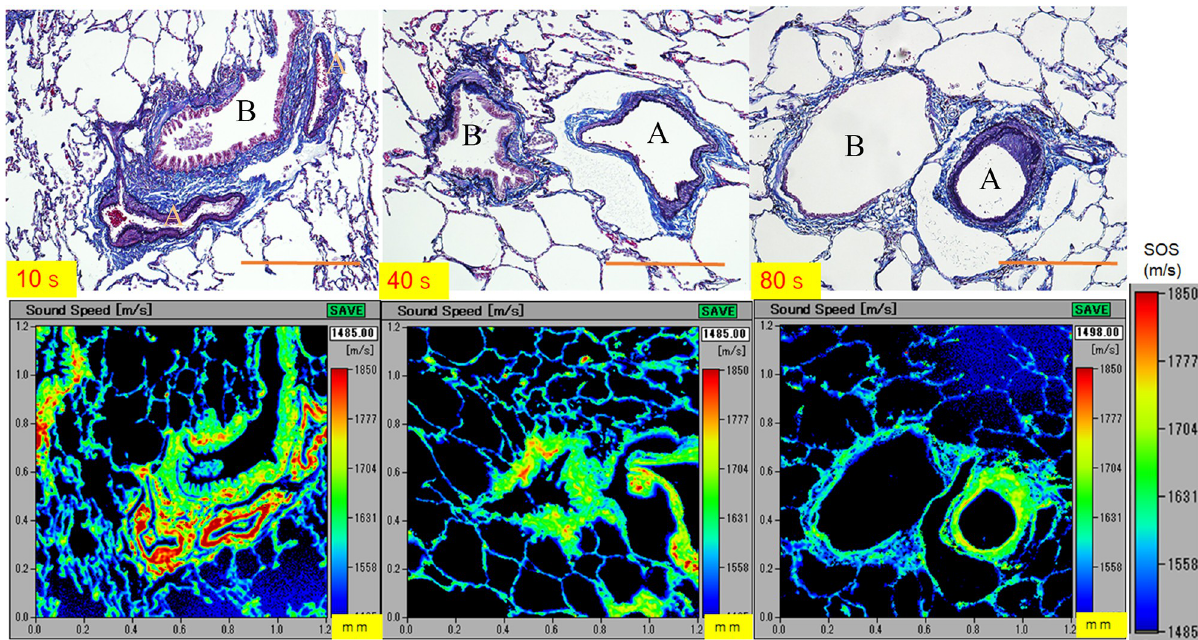
Fig 3. SOS images of the young, middle-aged, and old lungs. SOS values of the bronchioles, arterioles, and alveoli are high in the young group, which gradually become lower with the increasing age of the lungs, except for the intimal atheromatous region forming a ring shape in the arterioles of the old group, which exhibits high SOS values indicated as yellow. The corresponding LM images of sections stained with Verhoeff’s elastic and Masson’s trichrome. A, arteriole; B, bronchiole. Scale bar = 500 μ m.